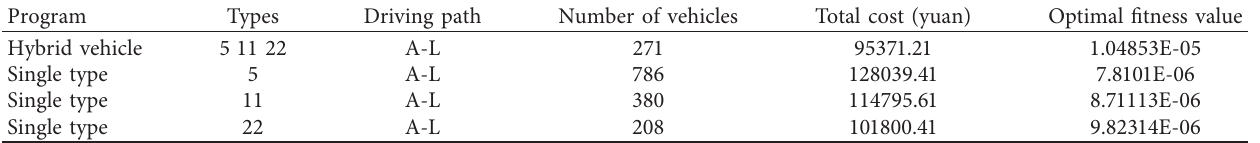
Table 9: Comparison of hybrid vehicle and single-type